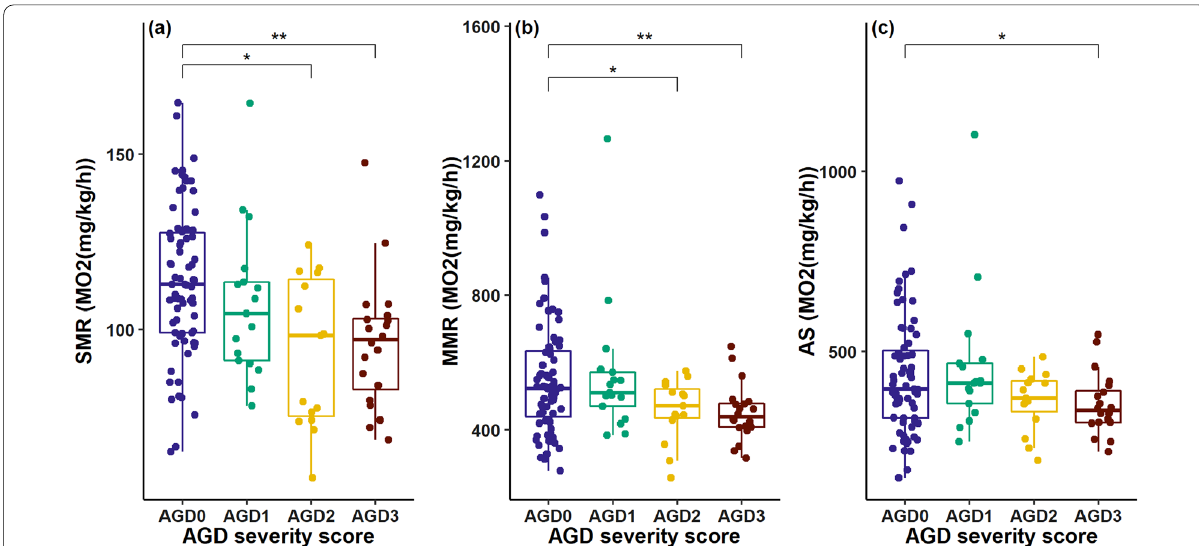
Fig. 3 Calculated oxygen consumption (MO 2 (mg/kg/h)) for fish affected by AGD at different severity levels. No differentiation between genetic background was made. Standard metabolic rate ( a ), maximum metabolic rate ( b ) and aerobic scope ( c ). Significance was determined by pairwise t -testing against weight adjusted metabolic rate measures of fish with an AGD score of 0. P -values adjusted by Bonferroni correction. Significance codes are only shown for significant results: ** p < 0.01; * p <